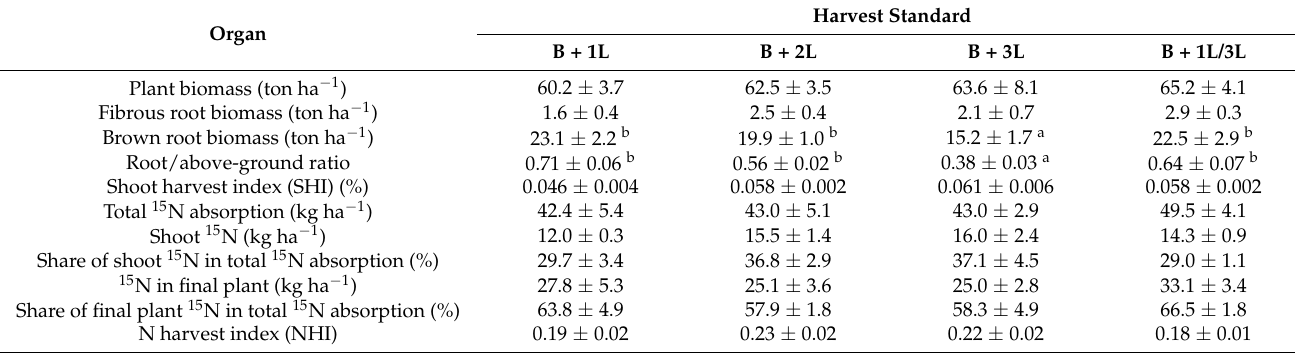
Different letters following data within the same line indicate significant ( p < 0.05) differences among harvest